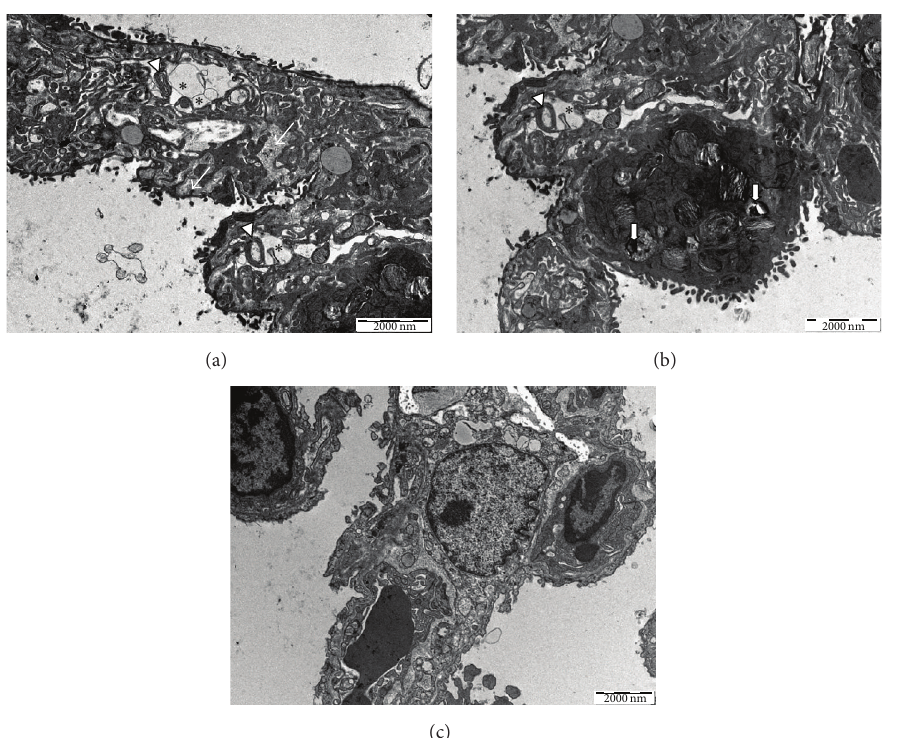
Figure 3: Ultrastructural analysis of lung after carrageenan-induced injury and DEC treatment; (a) and (b) lung sections from mice with carrageenan-induced pleurisy showing enhanced thickness of the interstitial space filled with collagen fibers (thin arrows), myelin bodies (arrowheads), vacuoles (asterisks), and lamellar bodies containing electrodense granules (short arrows); (c) lung treated with DEC presenting preserved pneumocytes; bar = 2000 nm.